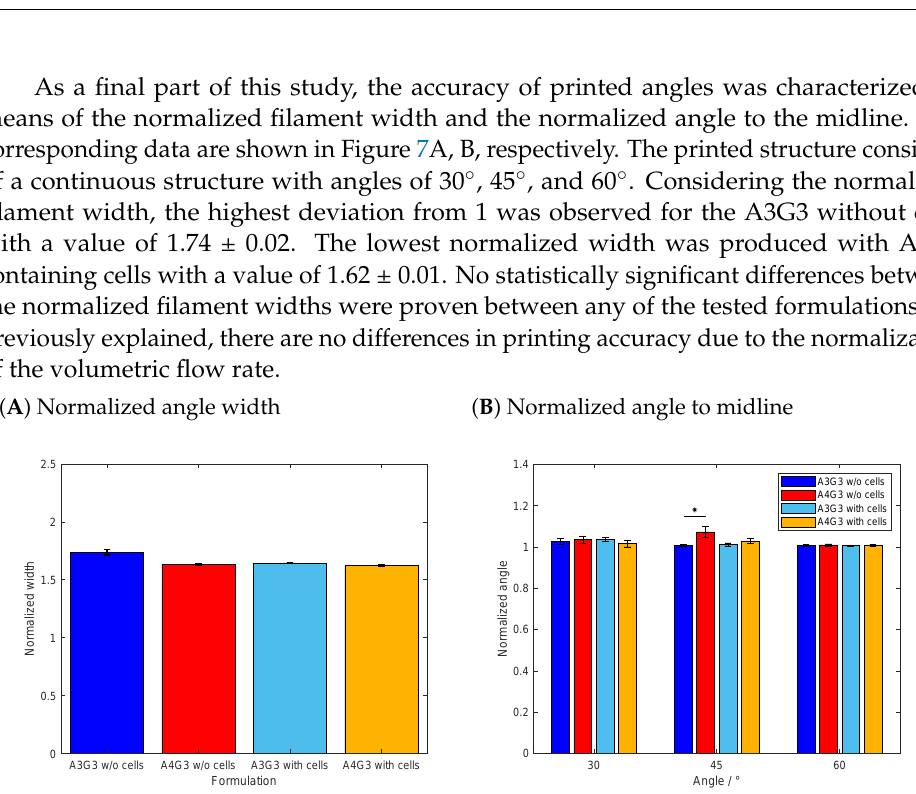
Figure 7. Printing accuracy study for the angle structure. In ( A ), the normalized line width is shown and, in ( B ), the normalized angle to the midline. For all four formulations, three biological replicates ( n = 3) were produced, and eight technical replicates ( n = 8) printed for each structure, resulting in a total of 24 objects, of which the mean is shown in a bar with the associated standard deviation. Significant differences are denoted with an asterisk ( p <